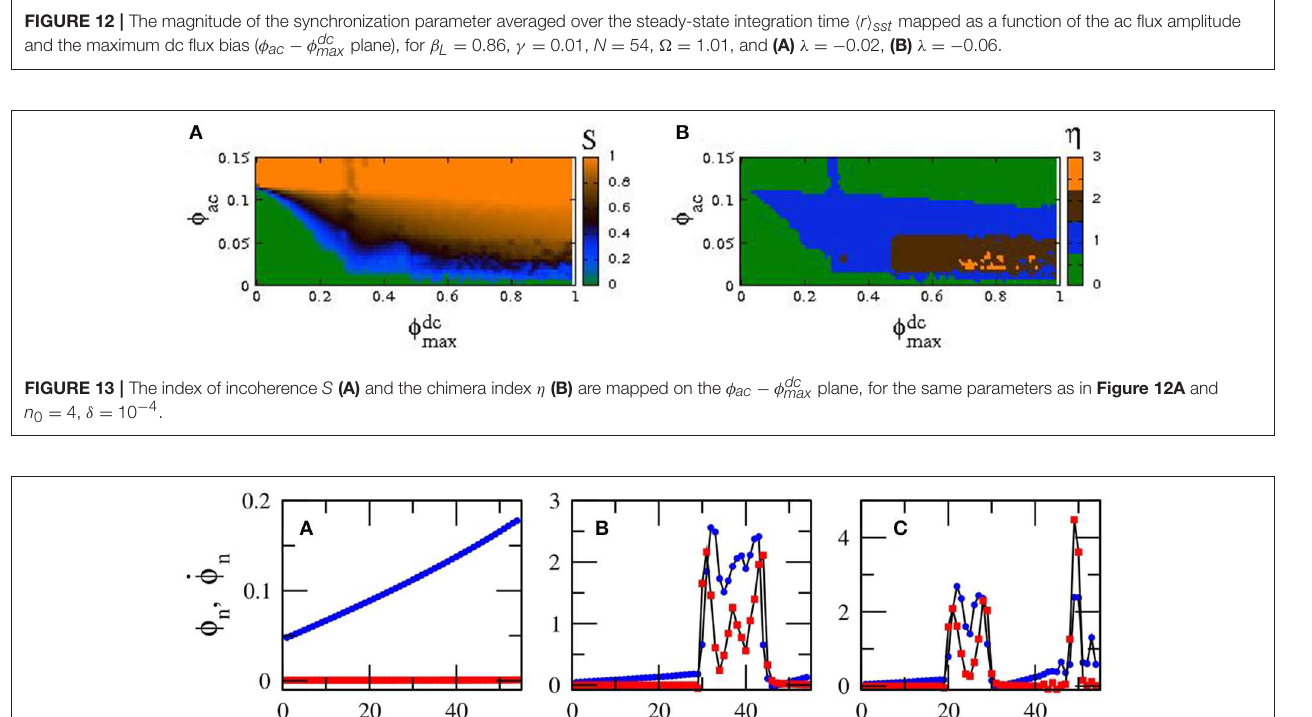
φ n (red), respectively, as a function of n for β L = ˙